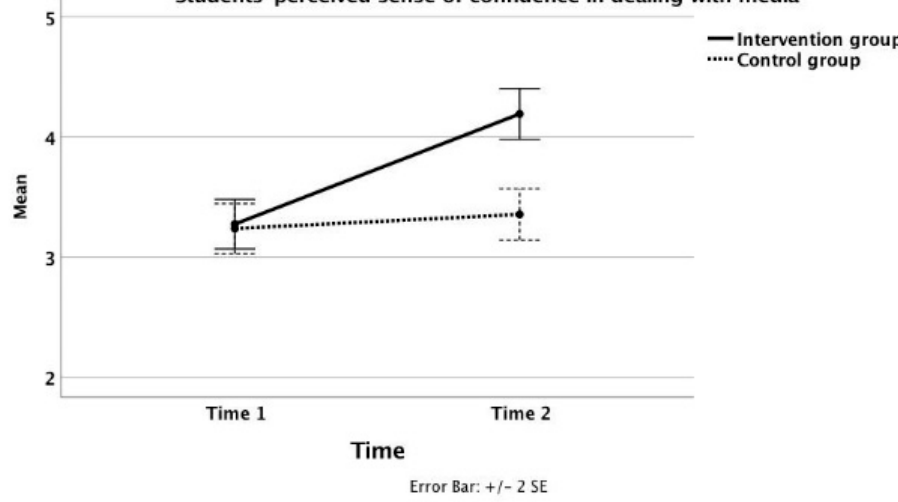
Figure 1. The students’ self-efficacy across experimental conditions and across